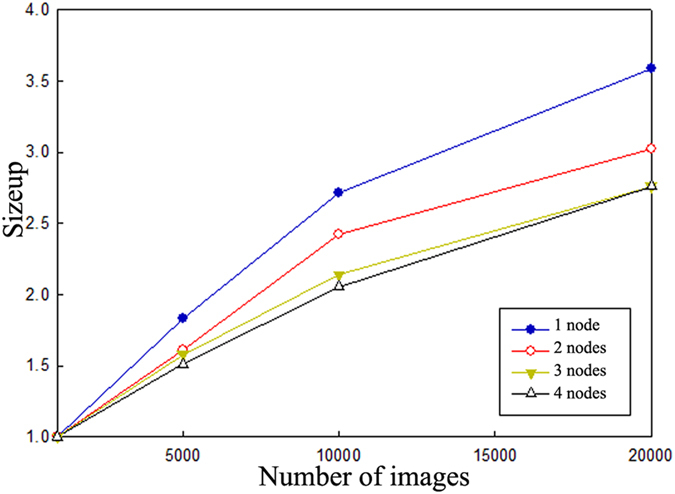
Sizeup comparison.